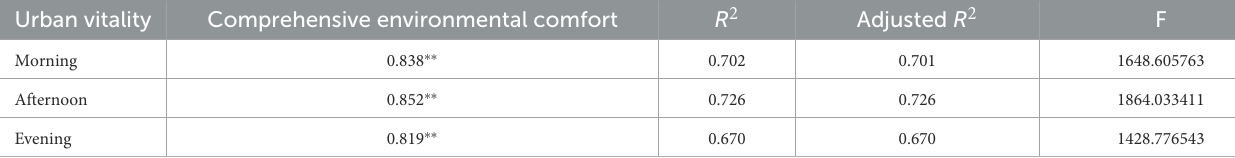
TABLE 5 Results of the OLS regression analysis of the impact of comprehensive environmental comfort on urban vitality. Urban vitality